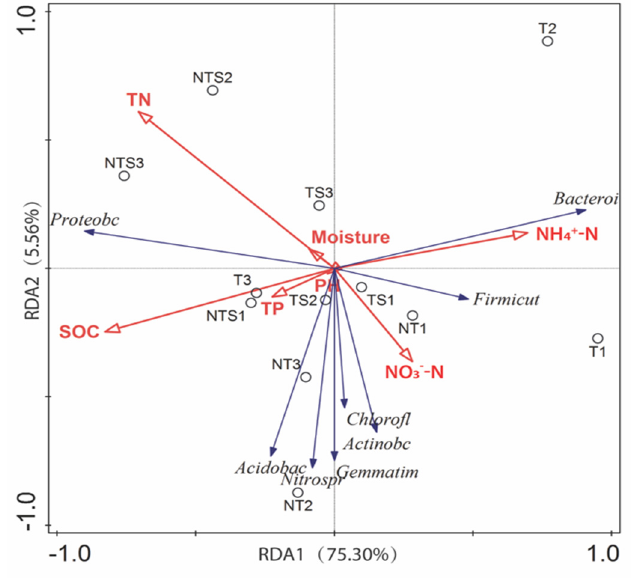
Figure 5. Summary of redundancy analysis, showing the relationships between soil parameters and soil bacterial community structure. Red lines represent soil parameters, blue lines represent the bacterial phylum-level taxonomy, and empty circles represent soil samples from all replications ( n = 3) of each tillage and crop residue management treatment. SOC, soil organic carbon; TN, total nitrogen; TP, total phosphorus; NT, no-tillage with all crop residue removed at harvest; NTS, no-tillage with crop residue chopped and spread evenly on the soil surface; T, conventional tillage with all crop residue removed at harvest; TS, conventional tillage with all crop residue chopped, spread evenly on the soil surface, and incorporated into the soil via plowing. Numbers following treatment abbreviations denote the experimental replication.